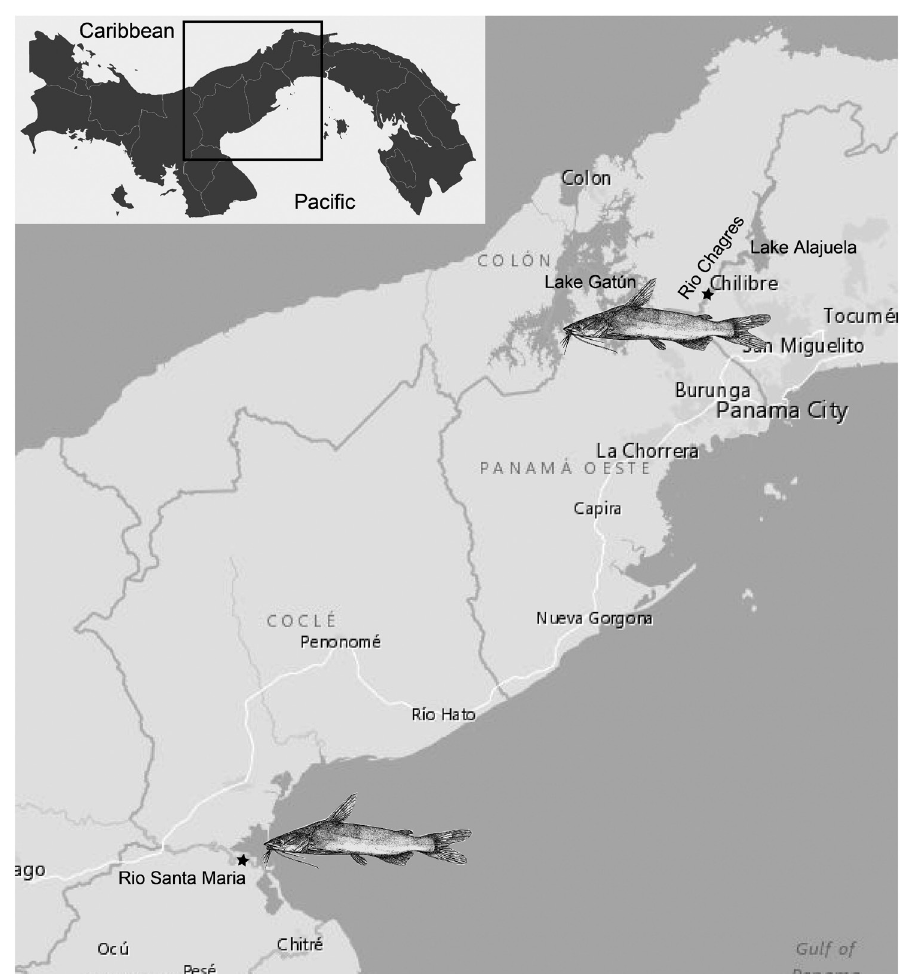
FIGURE 1 | Map of Panama and the two sampling locations indicated with stars: in Rio Santa Maria near Paris, Herrera (08°07’04.4”N 80°33’01.7”W) and in Rio Chagres, Puente del Rio Chagres, near Gamboa, Colon (09°11’34.66”N 79°39’9.42”W). We collected 50 fish from the Rio Chagres and 51 fish from the Rio Santa